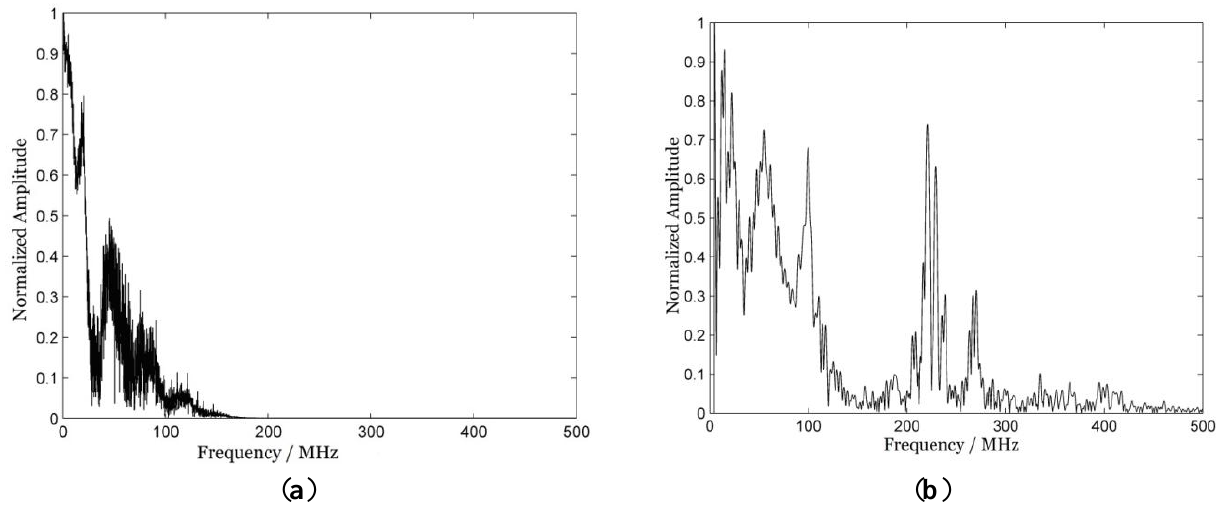
Figure 2. Normalized amplitude spectra of SAW signals of the piezoelectric LSAW and differential confocal LSAW detection techniques, respectively.